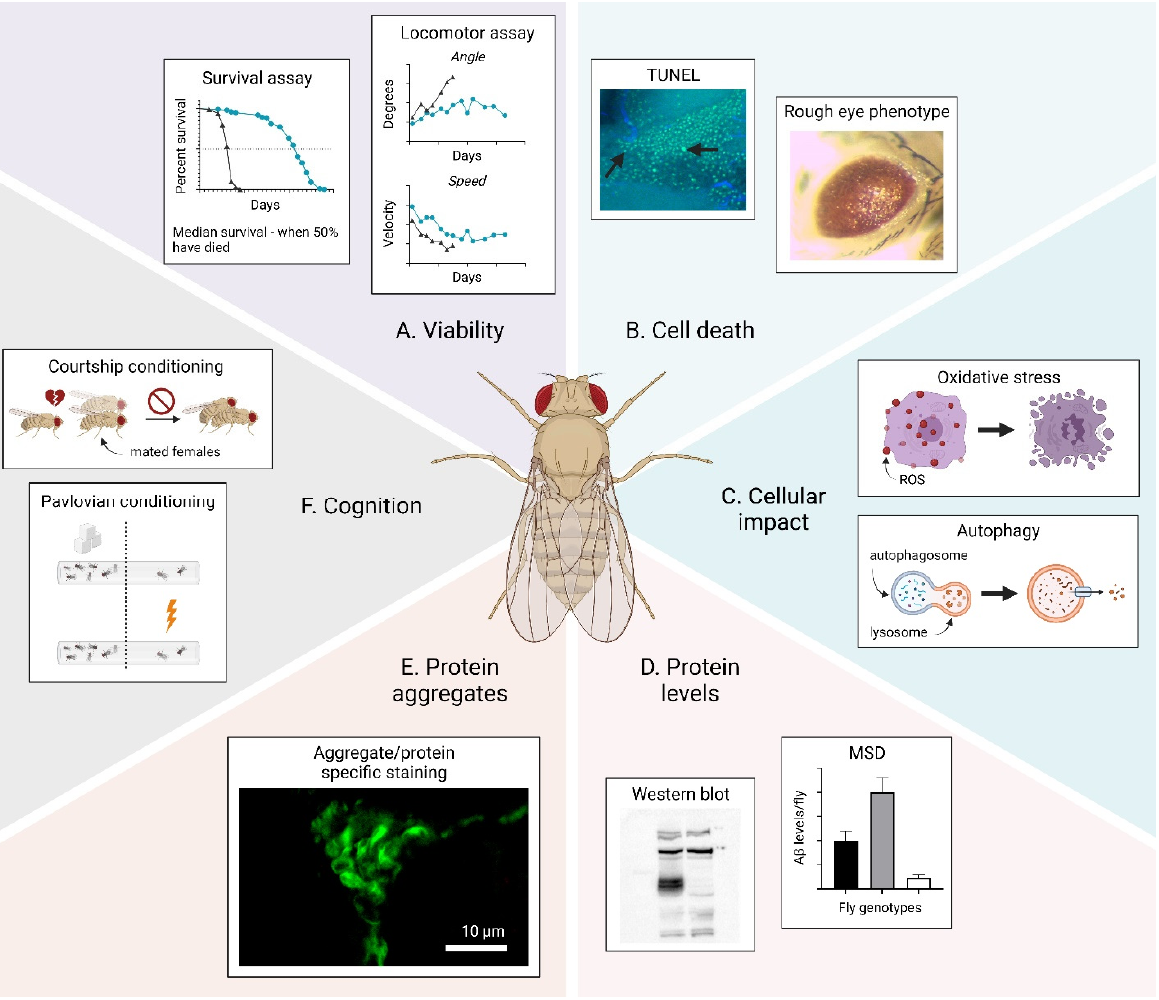
Figure 1. Overview of phenotypes that can be assessed to examine proteotoxicity in Drosophila . ( A ) Viability. ( B ) Cell death. ( C ) Cellular impact. ( D ) Protein levels. ( E ) Protein aggregates. ( F ) Cognition. The arrows in ( B ) show apoptotic cells. The figure was generated using BioRender.